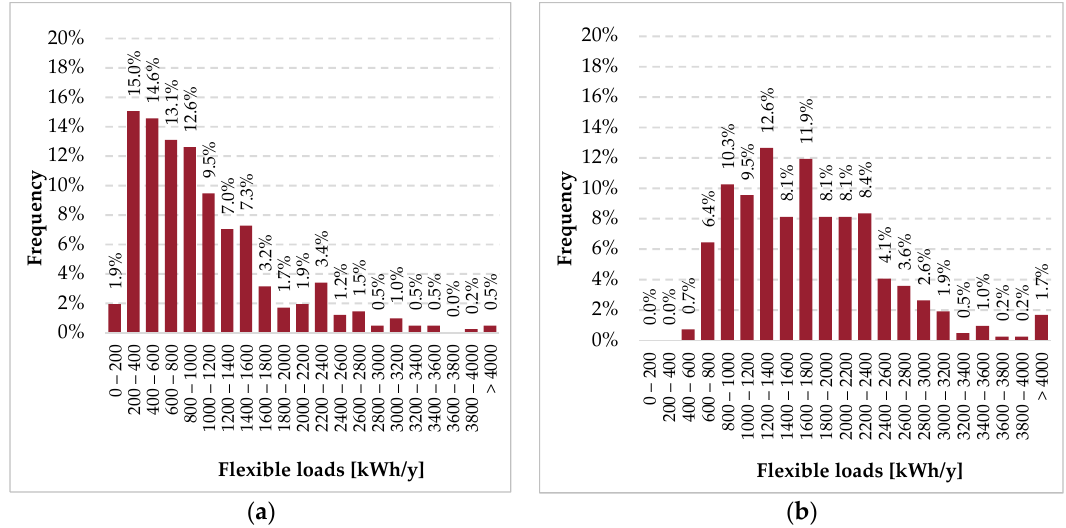
Figure 14. Flexible loads distribution. ( a ) Status quo #0; ( b ) after comprehensive intervention #15.